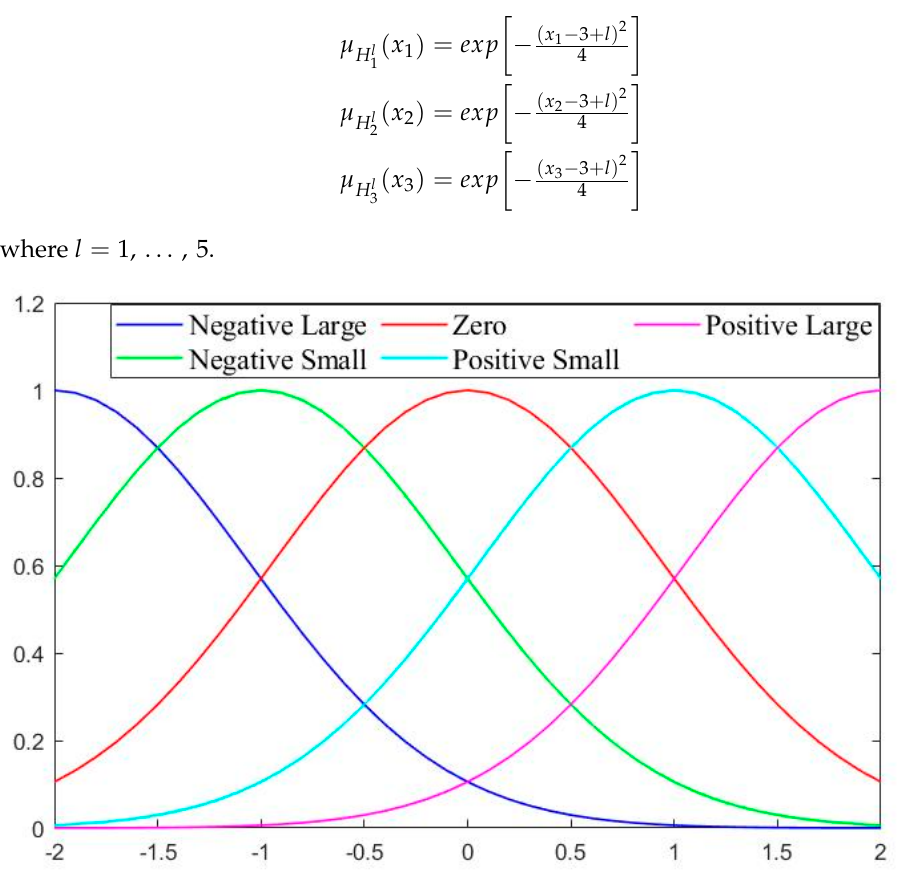
Figure 2. Fuzzy membership